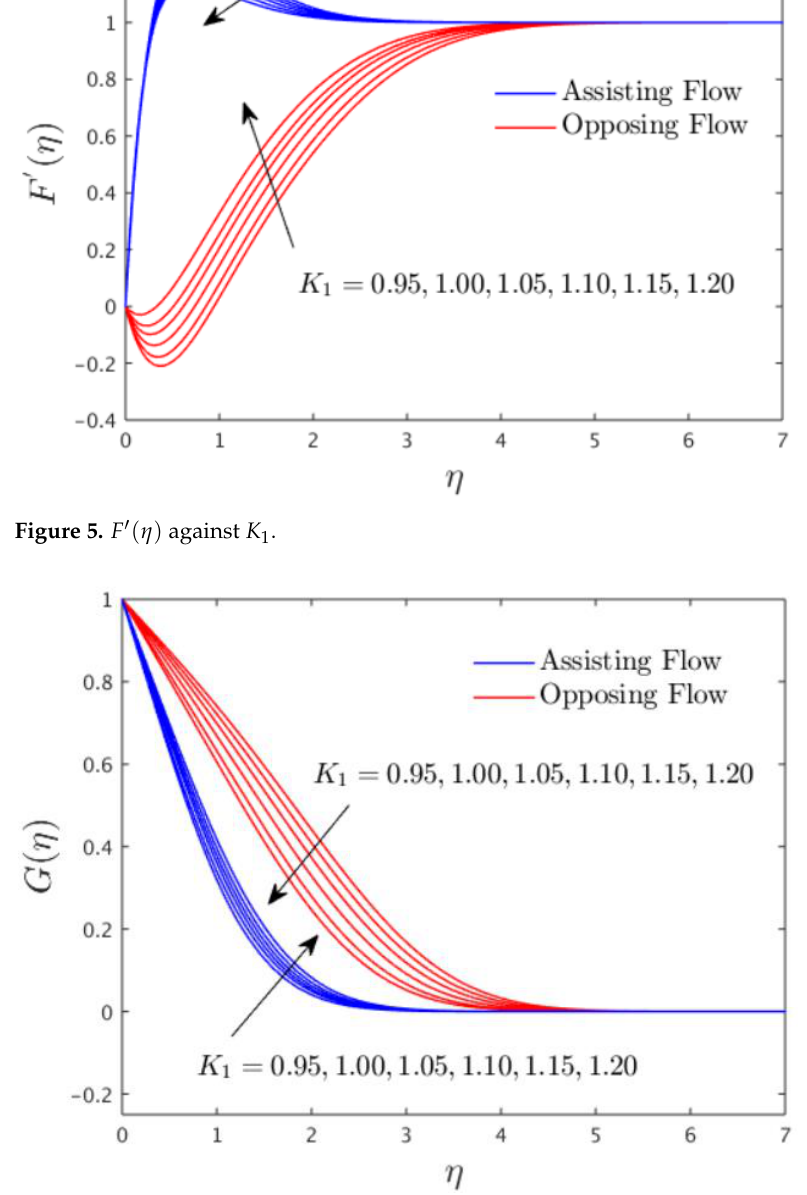
Figure 6.   G  against